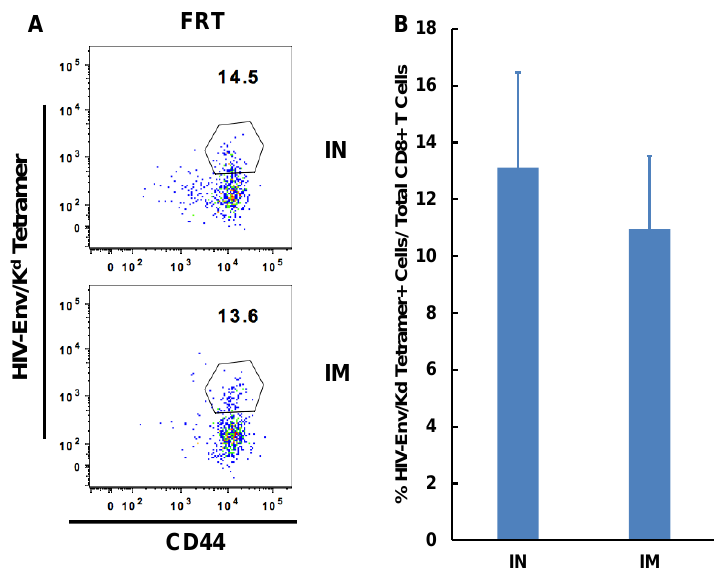
Figure 5. Intranasal immunization is as effective as intramuscular immunization at inducing HIV envelope-specific CD8 + T cell immunity in the FRT. Separate groups of mice (n = 3–6) were immunized by either IN route or intramuscular route with Adenoviral vector expressing HIV-1 envelope (Ad-Env). Mice were sacrificed on day seven post-immunization and lymphocytes were isolated from the female reproductive tract (FRT) and spleen. Localization and activation of antigen-specific CD8 + T cells in the different tissues was determined by flow cytometry. Representative scatterplot of activated antigen-specific CD8 + T cells cells in the different immunization groups is presented ( A ). Graphs with the average frequency of antigen-specific cells isolated from the FRT and spleen of each group are shown ( B ).